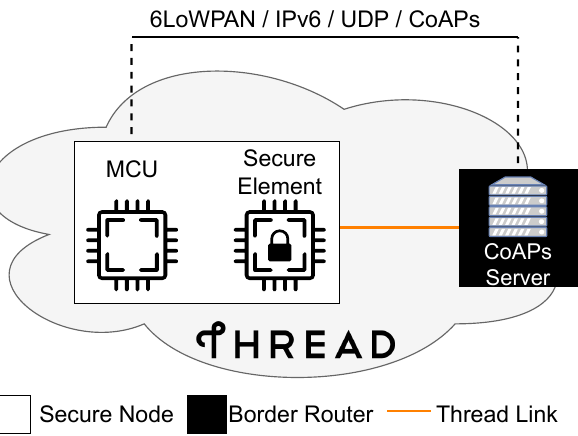
Figure 3. Test setup with reduced complexity to ensure reproducibility of results.